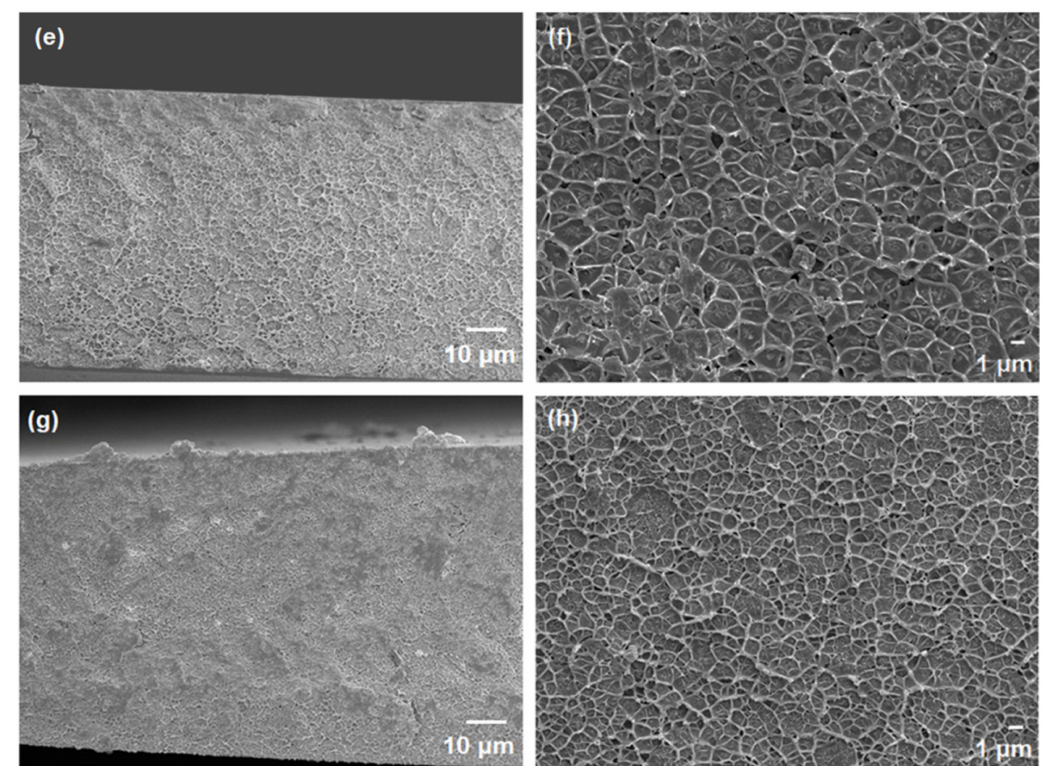
Figure 5. FESEM images of the mixed-matrix membranes: ( a , b ) 10 wt%, and ( c , d ) 20 wt% HKUST-1 with ODPA-TMPDA; and ( e , f ) 10 wt%, and ( g , h ) 20 wt% HKUST-1 with